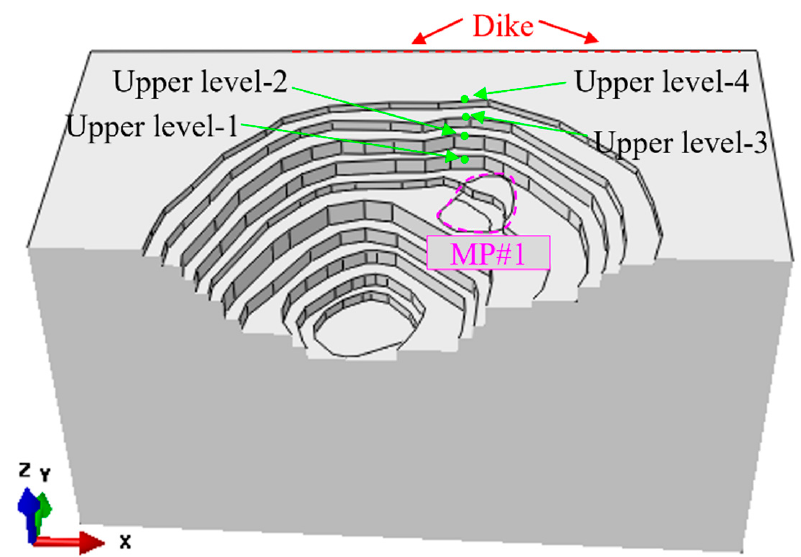
Figure 8. The chosen monitored location on the upper bench levels. The four selected upper levels are marked with upper level-1 (UL-1), upper level-2 (UL-2), upper level-3 (UL-3), and upper level-4 (UL-4), as shown in Figure 8. Here, upper level-4 (UL-4) is the ground surface at the mine. The elevation between the top surface of mining pipe MP#1 and the ground surface is 94 m. Therefore, the depths of the four bench levels are 0 m, − 14 m, − 34 m, and − 64 m, from upper level-4 (UL-4) to upper level-1 (UL-1), from the ground surface to the top surface of the bench level-1 (UL-1). The average displacements at the analyzed locations on the four upper bench levels in the numerical model caused by the mining activities and the three sill pillar recovery schemes process are presented in Figure 9. From the beginning of the mining production in mining pipe MP#1 to the state of three mining blocks which were all mined and backfilled, the process of mining and backfilling in pipe MP#1 caused the displacement of − 13.50 mm, − 11.56 mm, − 10.73 mm, and − 9.76 mm, from upper bench level-1 (UL-1) to upper bench level-4 (UL-4). Compared to the displacement of the monitored prisms at the